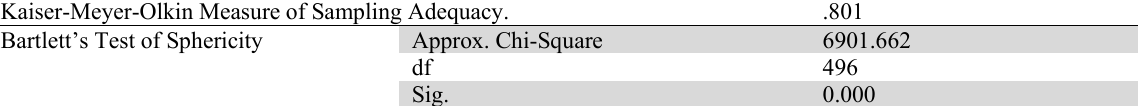
KMO and Bartlett’s Test Kaiser-Meyer-Olkin Measure of Sampling